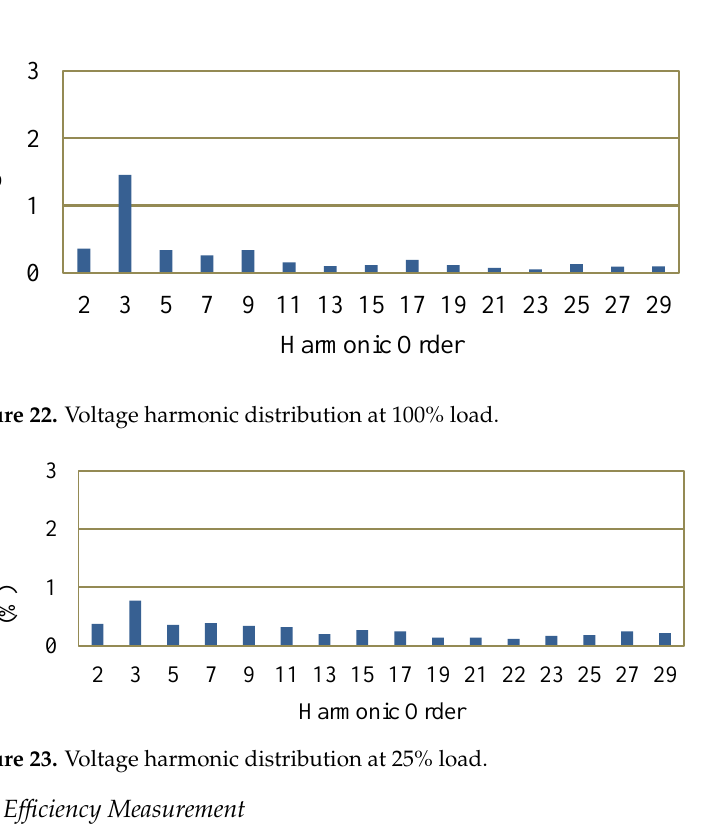
Figure 23. Voltage harmonic distribution at 25% load. Figure23. Voltage harmonic distribution at 25% load.